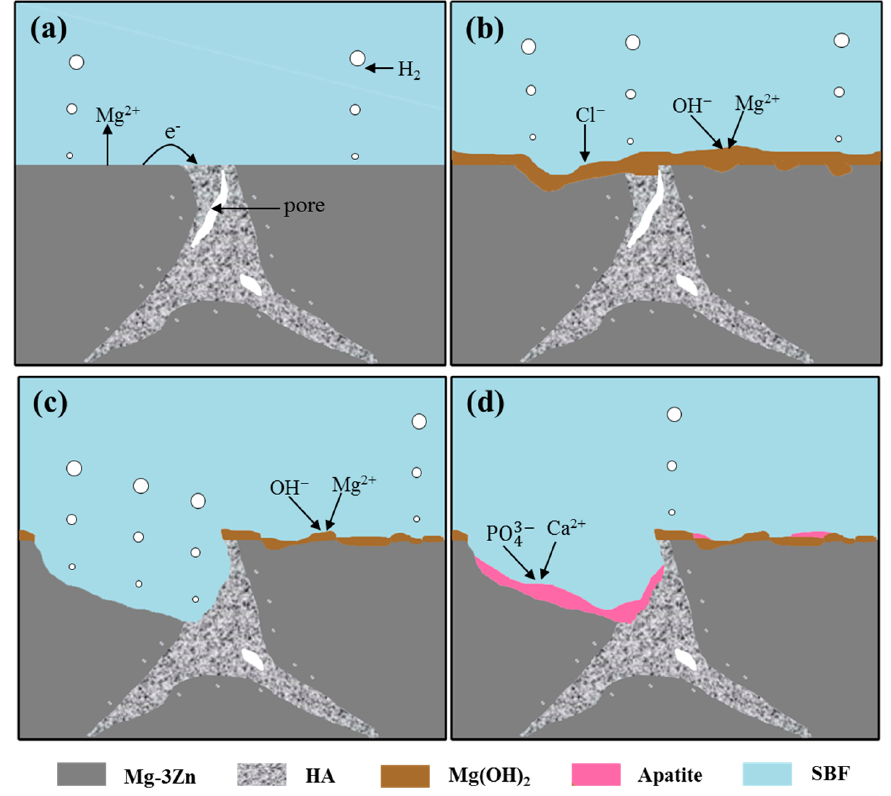
Figure 8. The schematic diagram displaying the degradation mechanism of the Mg-3Zn/ x HA composites.